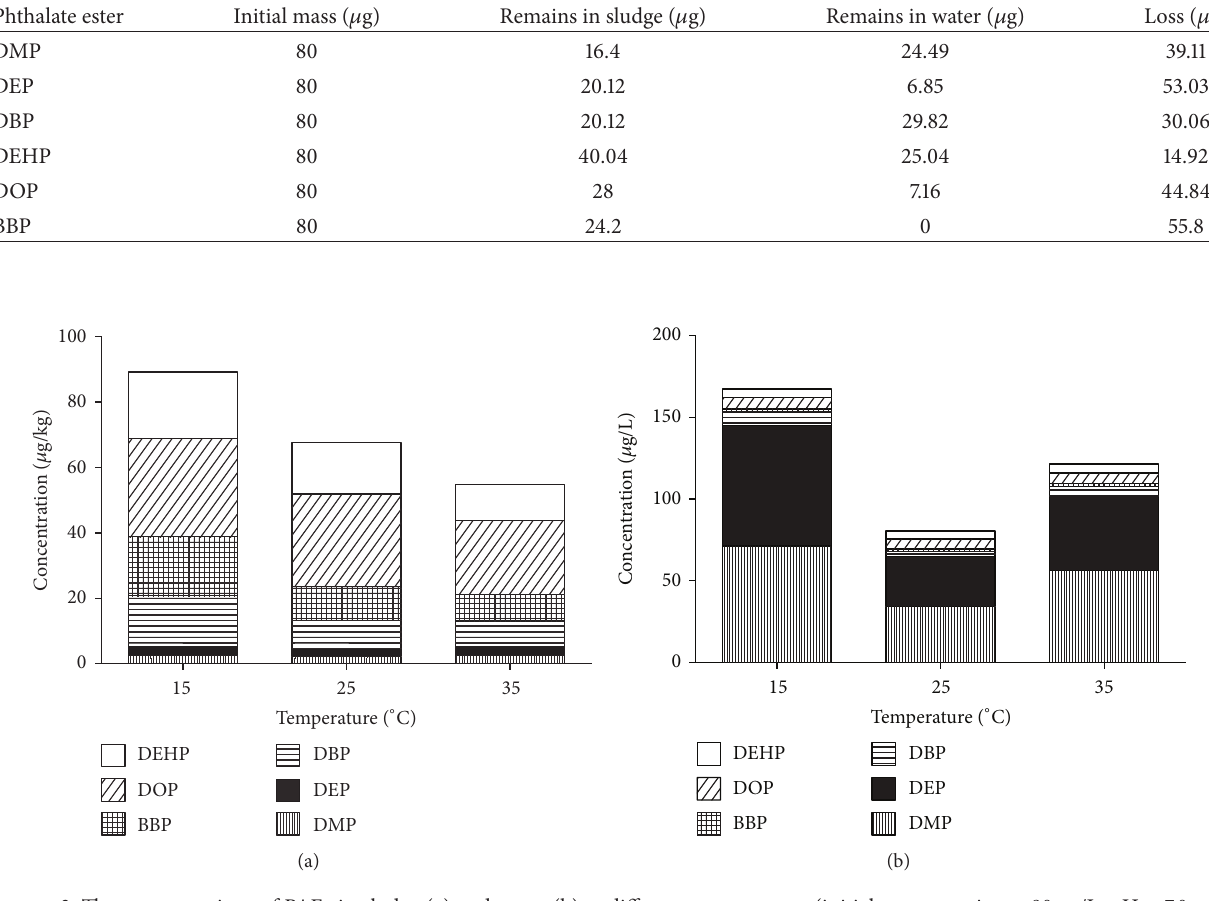
Figure 3: The concentrations of PAEs in sludge (a) and water (b) at different temperatures (initial concentration = 80 𝜇 g/L, pH = 7.0, and experiment duration = 2